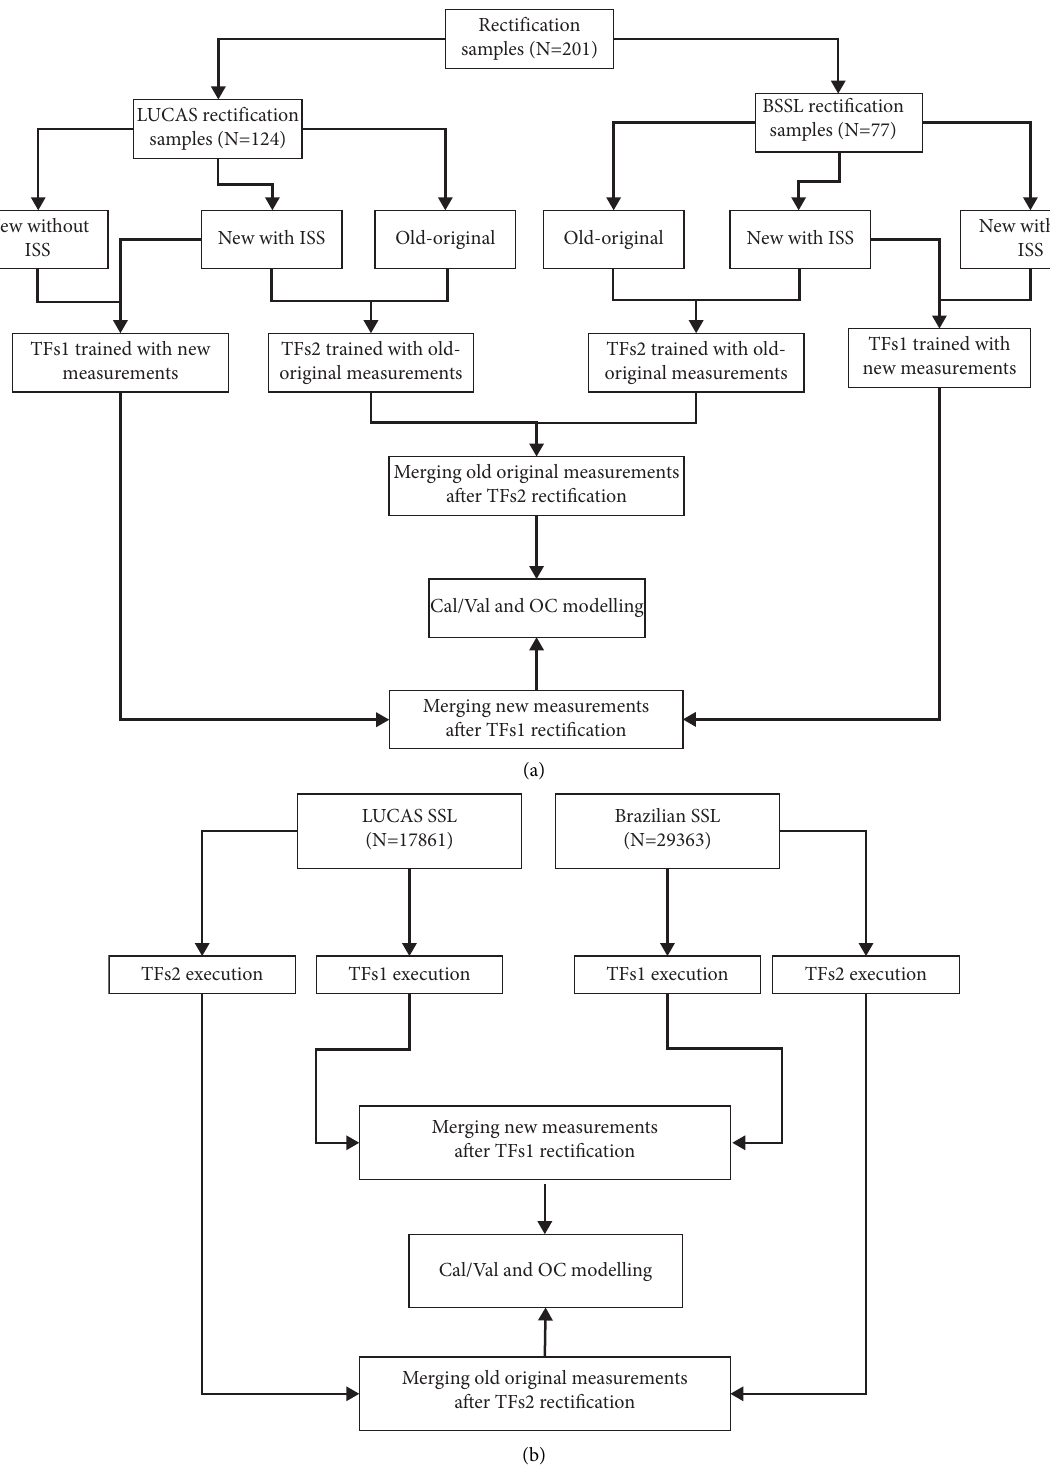
Figure 2: Flowcharts of the experiment: (a) steps to generate the TFs and model OC with the rectifcation groups; (b) steps to model OC using the original SSLs after execution of the